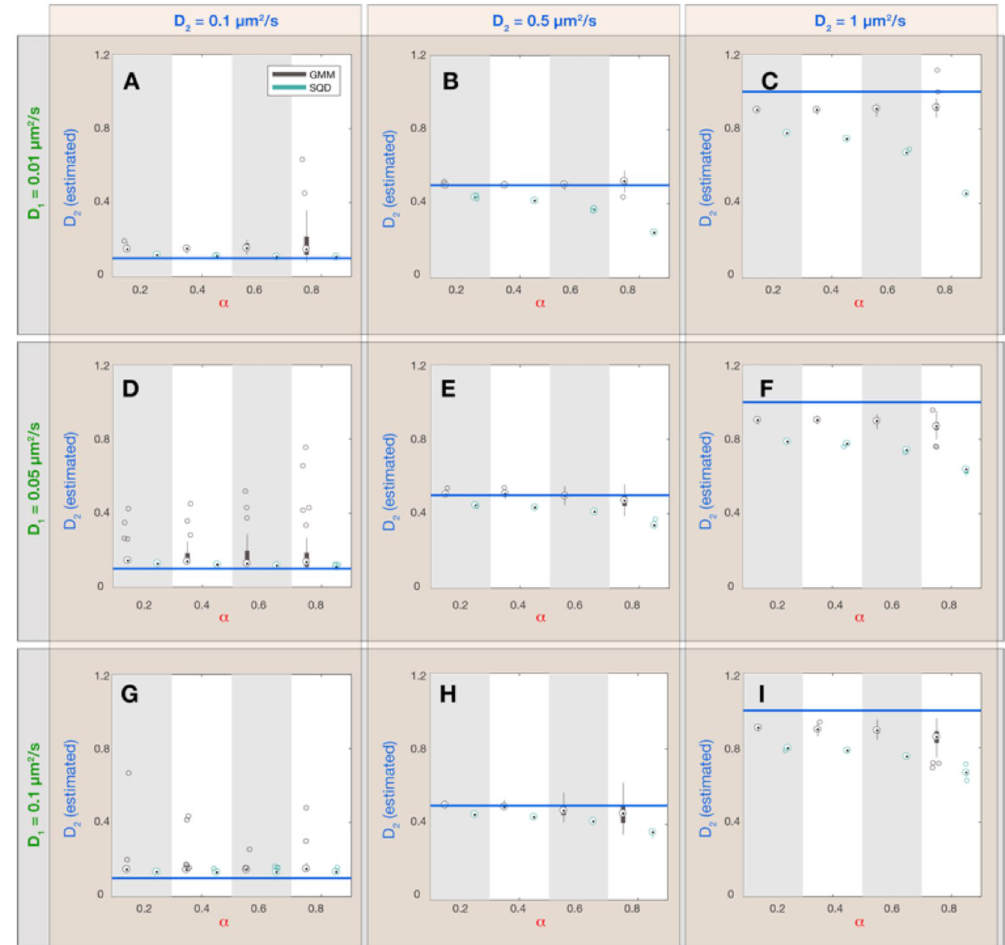
Figure 3. Dependence of estimated diffusion constant D (fast subpopulation) on simulation parameters and 2 inference method. Each panel (A–I) corresponds to a combination of simulation parameters D and D , as 1 2 indicated by the green and blue labels outside the plot panels, respectively. Within each panel 4 values of the fraction sizes α were chosen and synthetic simulations were performed on all parameter combinations. For each parameter combination ( D , D and α ) 30 simulations with 2000 tracks of 20 frames duration (see Table 1 for all 1 2 simulation parameters) were executed and the resulting data was analyzed with the GMM and SQD method, yielding two different estimates for the value of D (GMM: black boxplots; SQD: cyan boxplots). On each box, 2 the central mark is the median, the edges of the box are the 25 th and 75 th percentiles, the whiskers extend to the most extreme data points not considered outliers and the outliers are plotted as individual circles. The blue horizontal lines indicate the true value for D in the 2